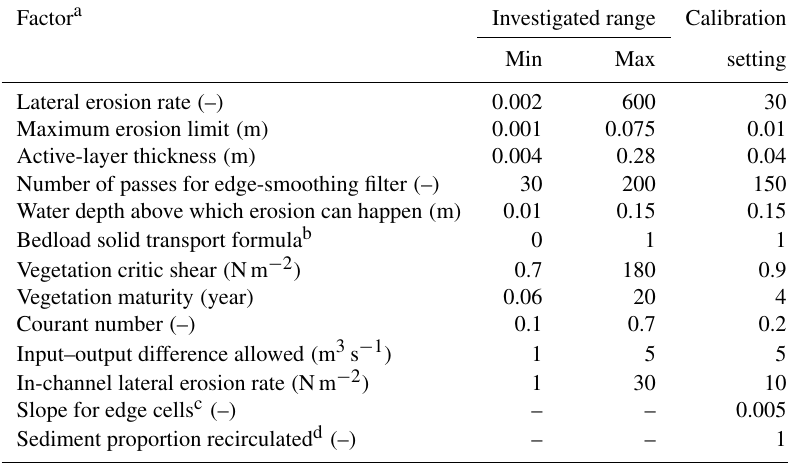
Table 3. Description of the CAESAR-LISFLOOD model calibrated factors. Factor a Investigated range Calibration Min Max setting Lateral erosion rate ( – ) 0.002 Maximum erosion limit ( m ) 0.001